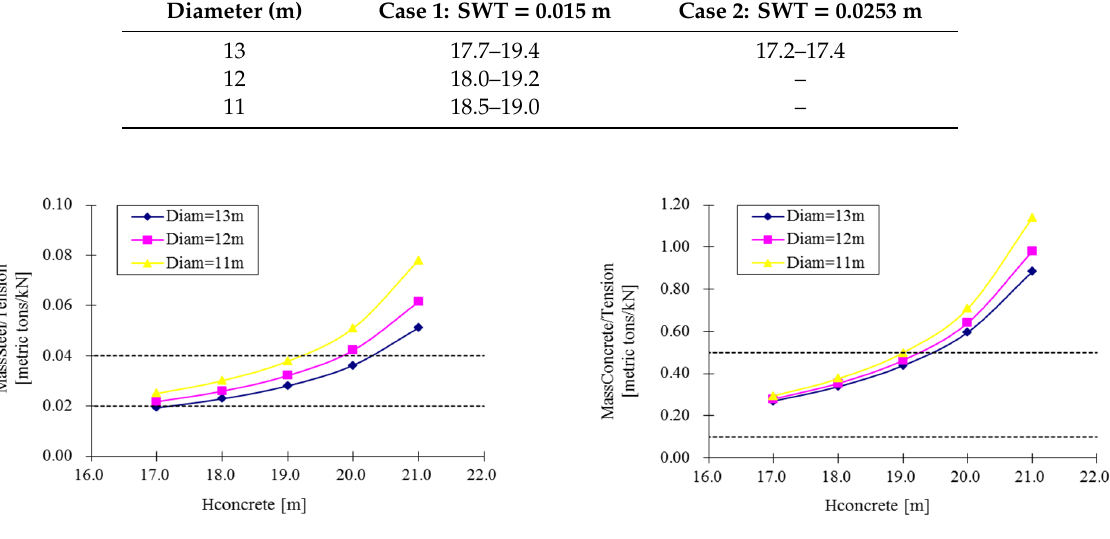
(b) (c) Figure 6. Optimized mass property ratio for three cases with SWT = ( a ) 0.015 m; ( b ) 0.0253 m and ( c ) 0.045 m. The region between the black dash lines represents the optimized cost regions. Table 6. Design result for concrete ballast height from step 1. Diameter (m)